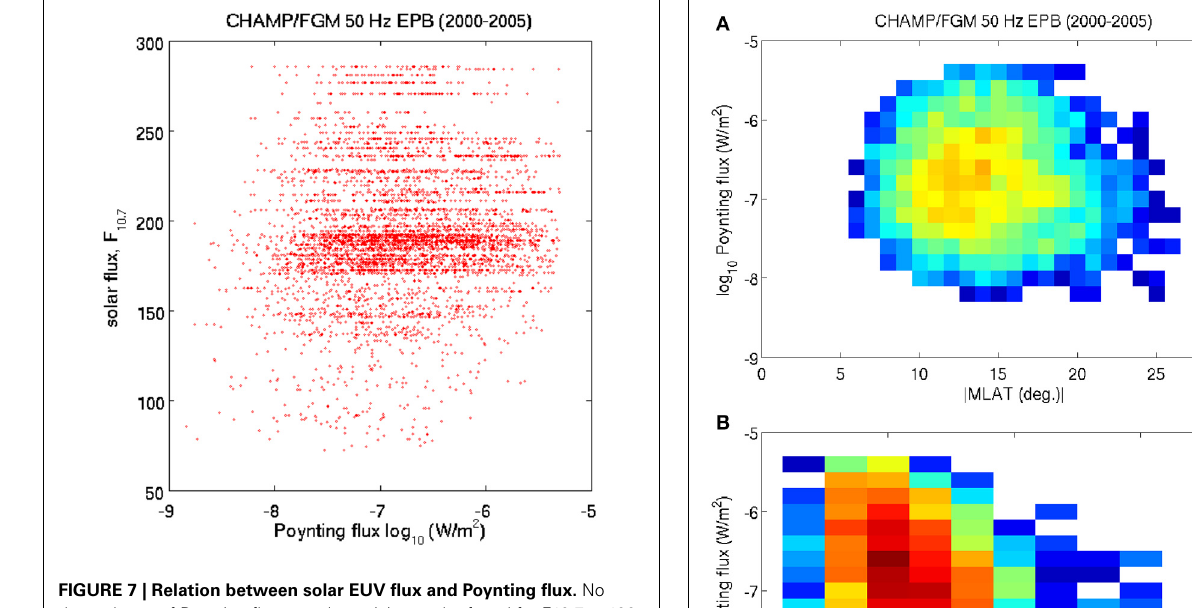
FIGURE 7 | Relation between solar EUV flux and Poynting flux. No dependence of Poynting flux on solar activity can be found for F10.7 > 100 sfu.